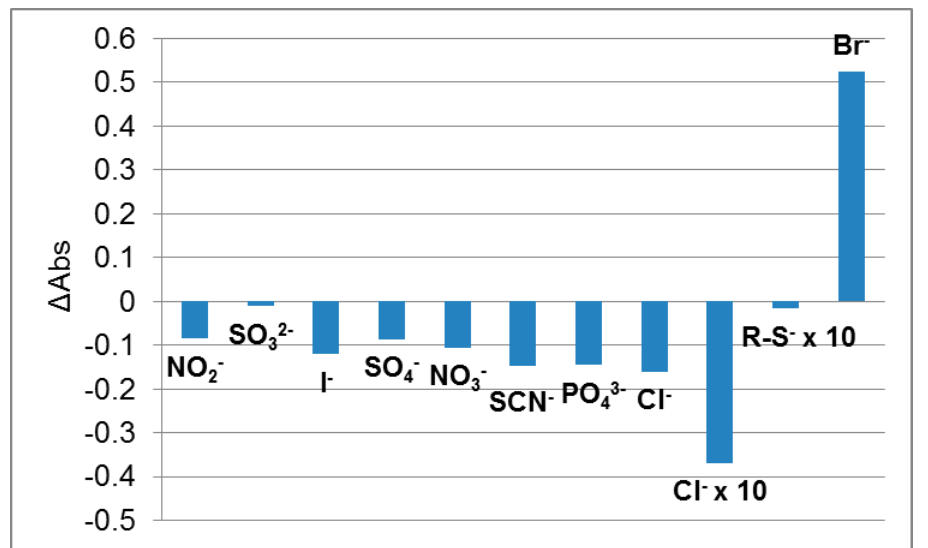
Figure 5. Graphical representation of the differences in absorption intensity produced by several interfering ions upon PtTMeOPP, at concentrations 100-fold or 1000-fold higher than that of Br − .